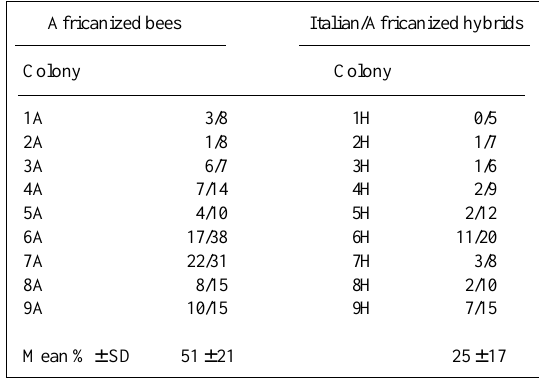
Table I - Proportion (number removed/number infested) of worker pupae artificially infested with Varroa jacobsoni, removed by the bees in Africanized (A) and Italian/Africanized hybrid (H)